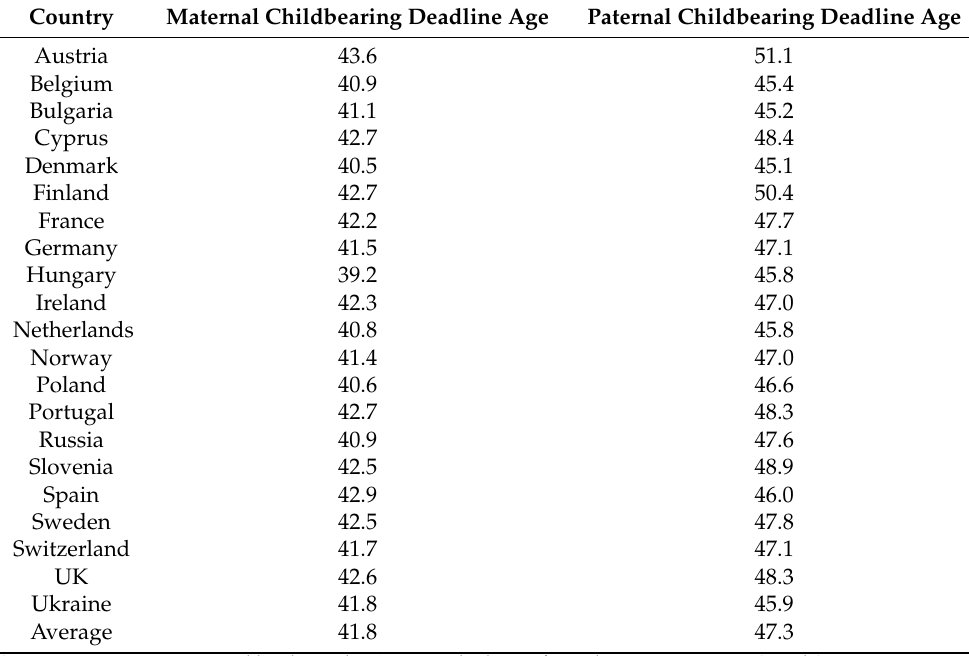
Table 2. Social perceptions of maternal and paternal deadline age for childbearing by countries.